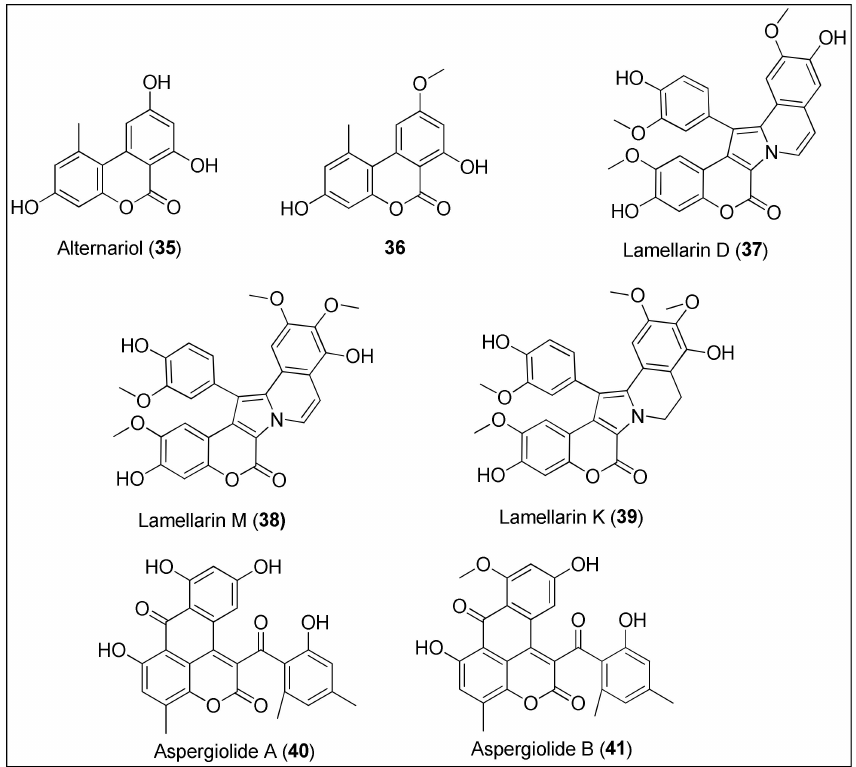
Figure 4. Chemical structures of coumarins: alternariol ( 35 ) and its analogue 36 isolated from the mangrove endophytic fungus 2240. Lamellarins D ( 37 ), M ( 38 ) and K ( 39 ) are obtained from the marine molluscs of the genus Lamellaria . Aspergiolides A ( 40 ) and B ( 41 ) are extracted from the marine fungus, Aspergillus galucus